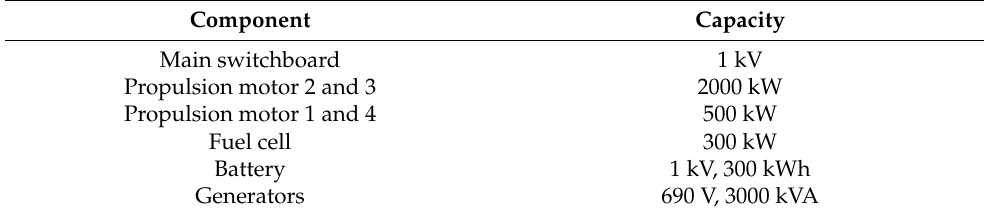
Figure 2. Single-bus structure of a DC shipboard MG, M: motor, G: generator. Table 1. Typical electrical ratings of a DC shipboard, adapted from